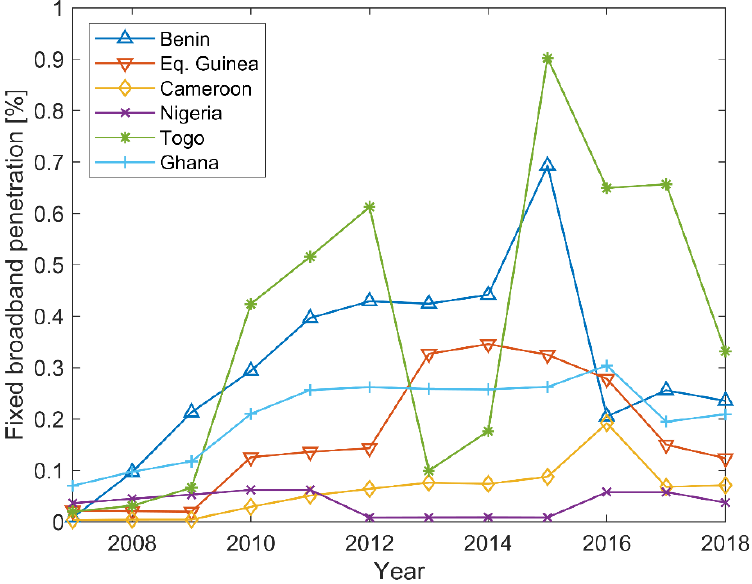
Figure 2. Fixed Broadband penetration in the Gulf of Guinea (based on data available from [26]).